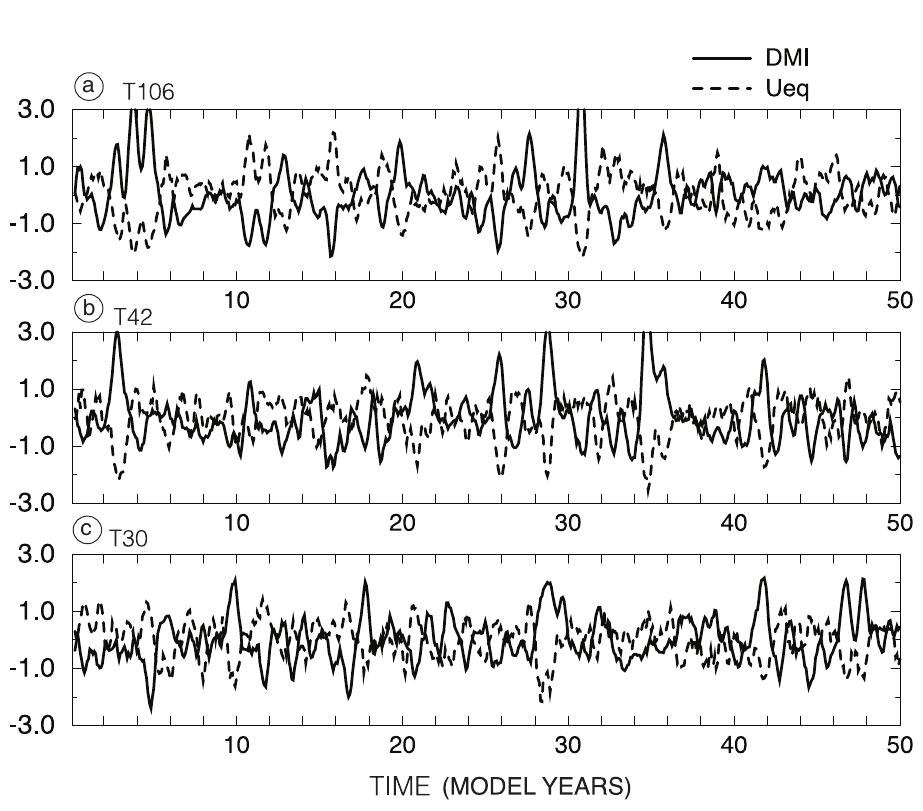
Fig. 17a-c. Solid line curve, time series of the Dipole Mode Index (DMI) defined as the SST anomaly between the WIO (50 ° E-70 ° E; 10 ° S-10 ° N) and the southern EIO (90 ° E-110 ° E; 10 ° S-Equator). Dashed line curve, time series of the zonal wind anomaly averaged over the region: 70 ° E-90 ° E; 5 ° S-5 ° N. Panel a): T106 experiment; panel b): T42 experiment; panel c): T30 experiment.